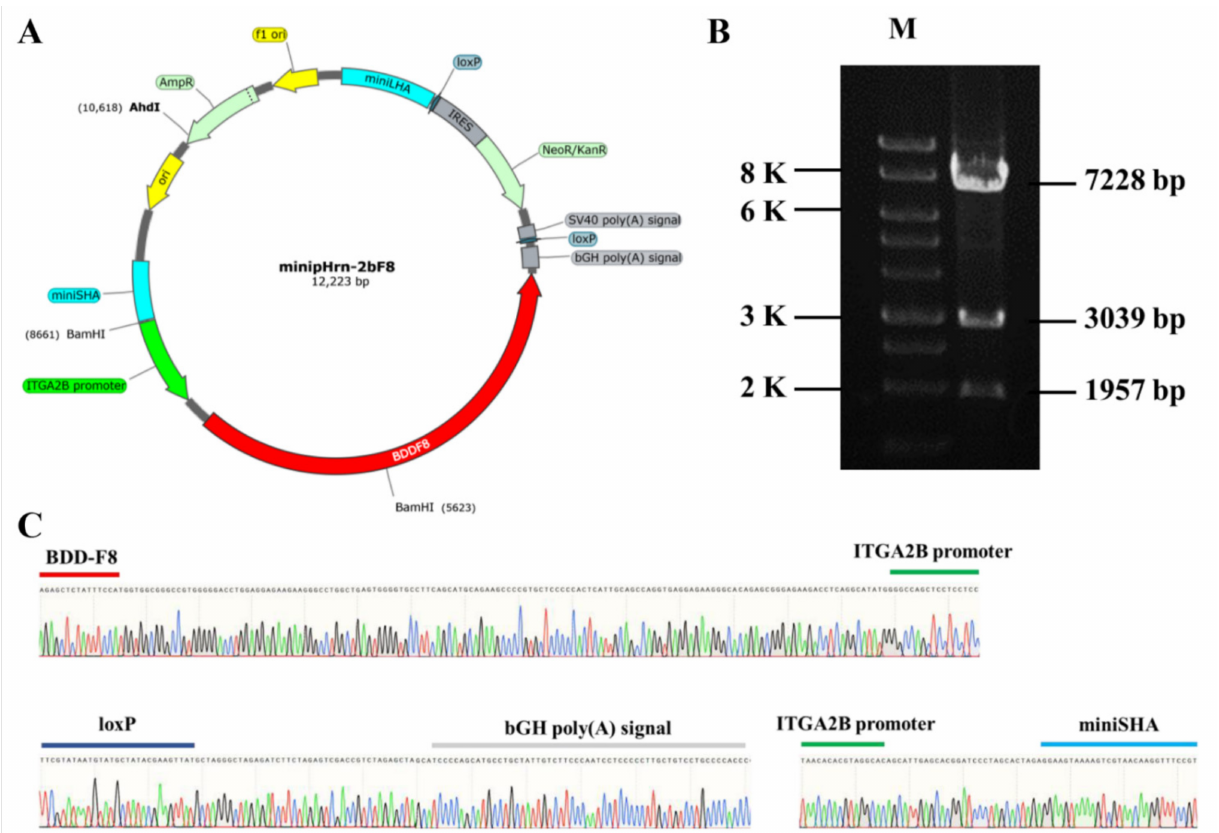
Figure 1. Construction of nonviral targeting vector minipHrn-2bF8. ( A ) The structure of the minipHrn-2bF8. ( B ) The plasmid minipHrn-2bF8 was identified by restriction endonuclease (BamH1 and Ahd1) digestion. Agarose gel electrophoresis showed expected bands of 7228 bp, 3039 bp, and 1957 bp (M, 1 KB DNA ladder). ( C ) Sequencing analysis of truncated ITGA2B promoter (green) and BDDF8 (red), loxP (dark blue) and bGH poly(A) signal (gray), and short homologous arm (light